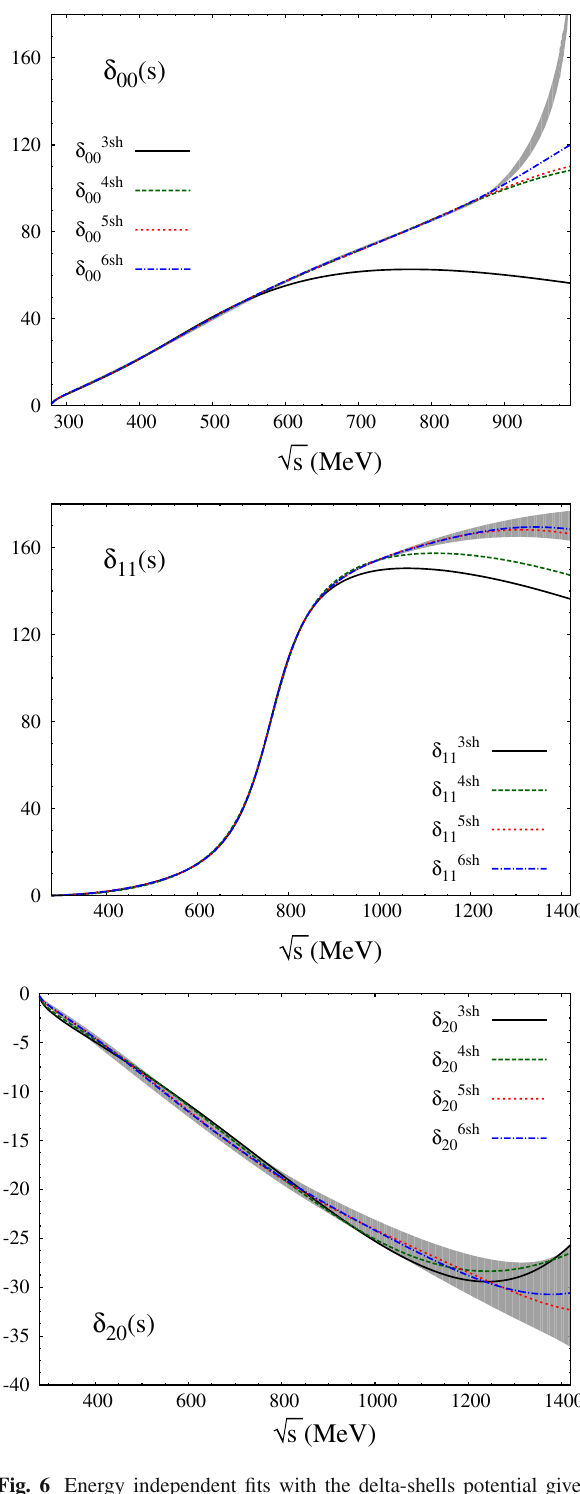
Fig. 6 Energy independent fits with the delta-shells potential given in (62) using (cid:14) r = 0 . 3 fm for the ππ S 0-, P - and S 2-wave phase shifts. The uncertainties are those quoted in [22], whereas solid-black, green-dashed, red-dotted and blue dot-dashed lines stand for for the central results for r c = 0 . 9 , 1 . 2 , 1 . 5 , 1 . 8 fm,